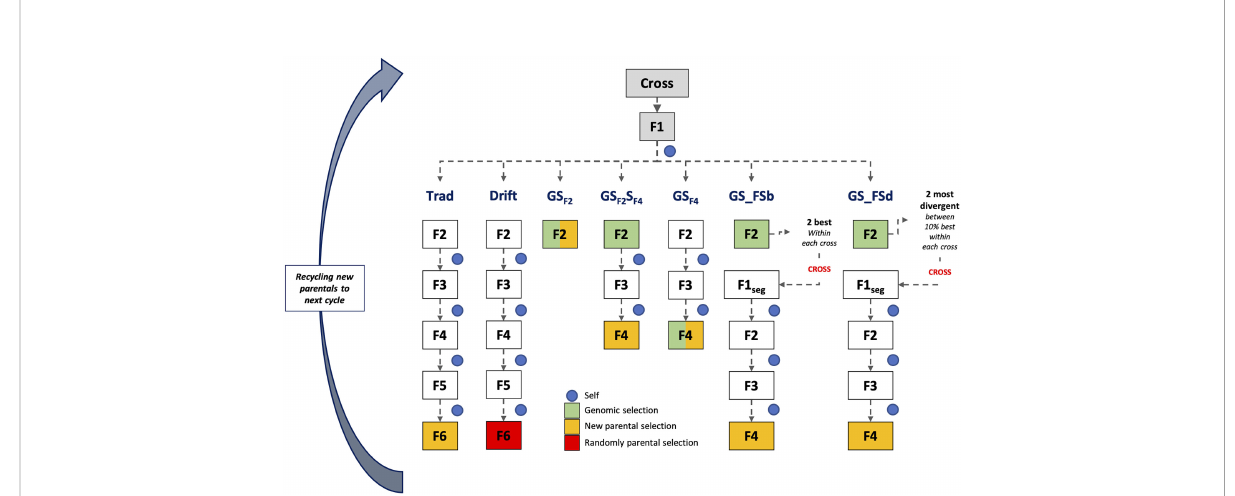
FIGURE 1 Scheme of the fi rst cycle of the long-term breeding schemes. At the end of each scheme, a parental group was selected for recycling and compounding the next cycle that works independently. Trad: traditional phenotypic selection; Drift: random selection; GS F2 : genomic selection performed in F2 stage; GS F2 S F4 : genomic selection performed in F2 stage and phenotypic selection performed in F4 stage; GS F4 : genomic selection performed in F4 stage; GS_FSb: genomic selection performed on F2 stage to select the two best individuals based on genomic estimated breeding values and crossed them to make a new recombination event; GS_FSd: genomic selection performed on F2 stage to select the two most divergent individuals and crossed them to make a new recombination